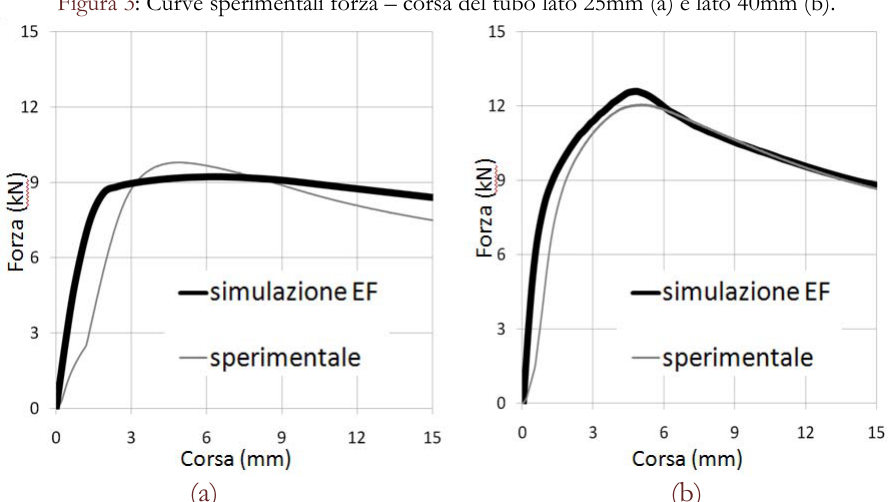
Figura 3: Curve sperimentali forza – corsa del tubo lato 25mm (a) e lato 40mm (b).